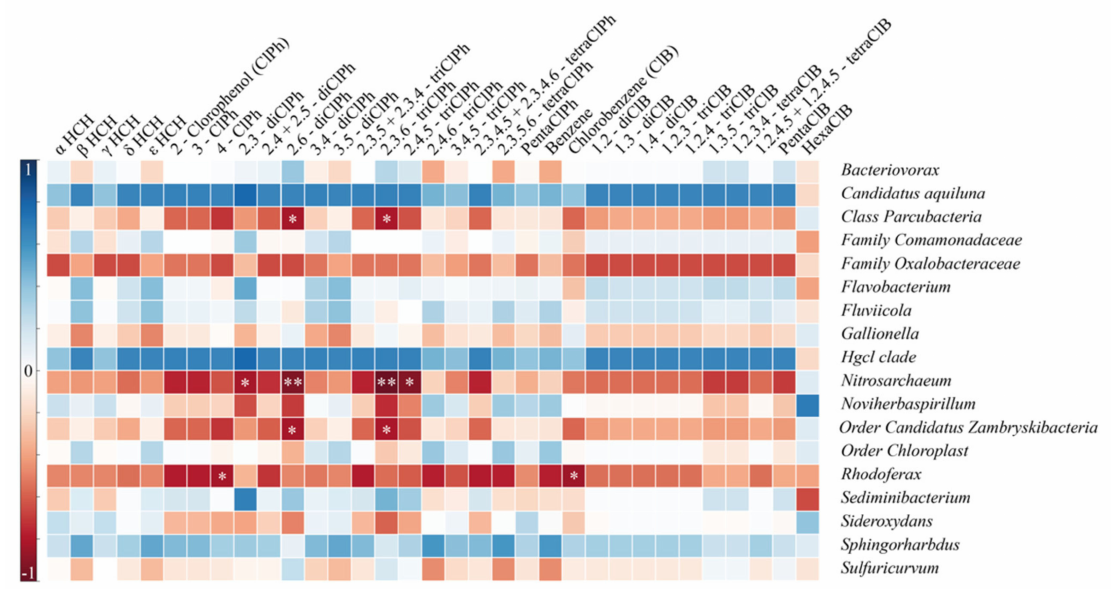
Figure 4. Spearman correlations for taxa to chemical compounds ** p < 0.01, * p <